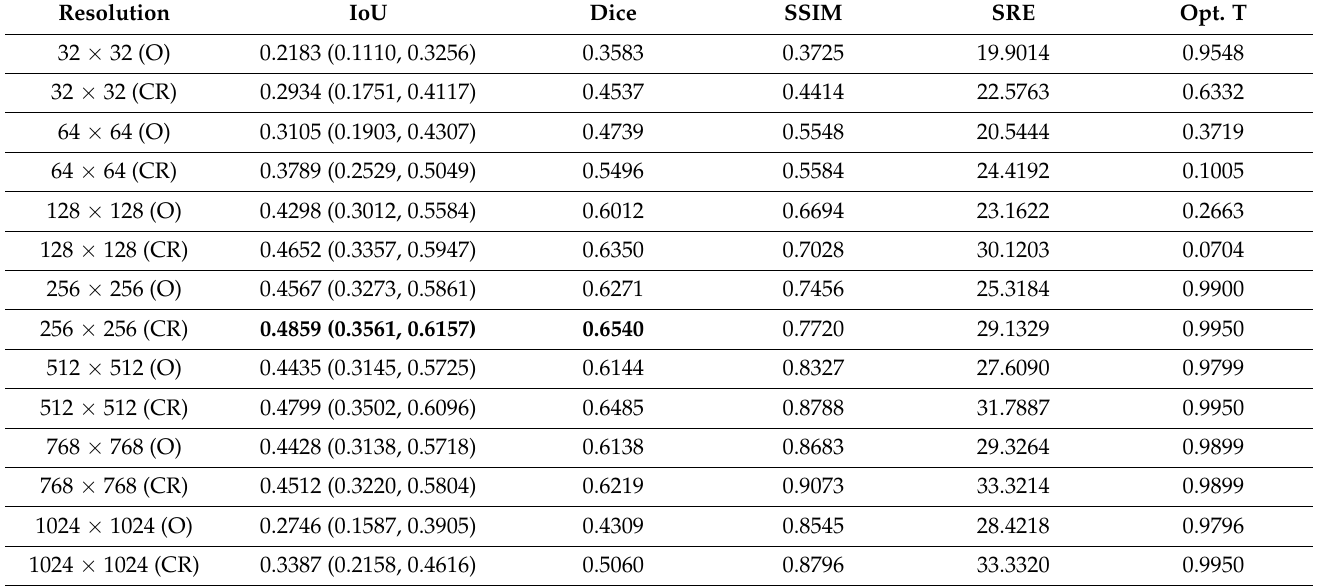
Table 3. Performance achieved by the Inception-V3-UNet model with original and lung-cropped CXRs and TB-lesion-consistent masks. The term SRE, O, CR, and Opt. T denotes signal-to-reconstruction error ratio, original CXRs and TB-lesion-consistent masks, lung-ROI-cropped CXRs and TB-lesion-consistent masks, and the optimal segmentation threshold. Values in parenthesis denote the 95% CIs as the Exact measure of the Clopper–Pearson interval for the IoU metric. The bold numerical values denote superior performance for the respective